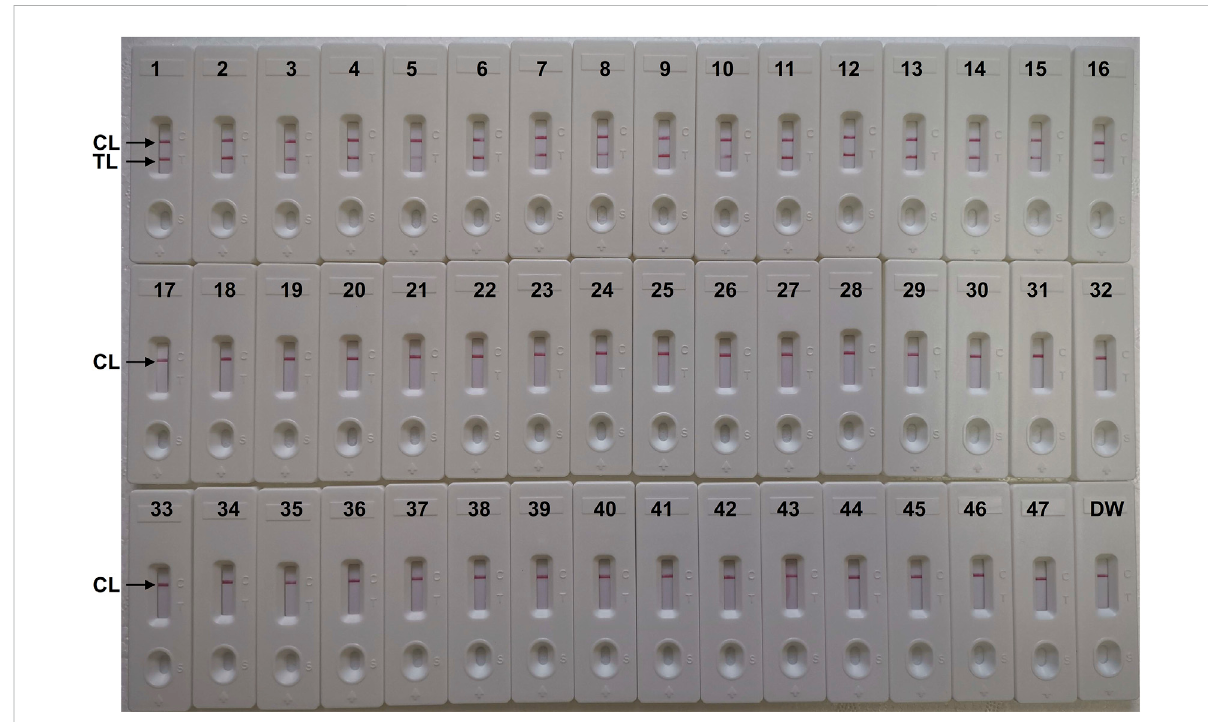
FIGURE 7 The speci fi city of C. albicans -LAMP-LFB assay for different strains. The C. albicans -LAMP-LFB assay was evaluated with different strains genomic DNA as templates. Two crimson lines (TL and CL) were appeared on the LFB, indicating positive results for the C. albicans isolates. Only a visibleredline(CL)atthedetectionzoneofLFB,reportingthenegativeresultsfornon- C.albicans strainsandblankcontrol(DW).Biosensor1,Positive control ( C. albicans ATCC 10231), Biosensors 2-16, isolated C. albicans strains; Biosensor 17, Candida dubliniensis ; Biosensor18, Candida tropicalis (ATCC 13803); Biosensors19-23, isolated Candida tropicalis strains; Biosensors 24-28, isolated Candida krusei strains; Biosensors 29-33, isolated Candida glabrata strains; Biosensors 34-38, isolated Candida parapsilosis strains; Biosensor 39, Cryptococcus neoformans ; Biosensor 40, Penicillium mameffei ; Biosensor 41, Candida stellatoidea ; Biosensor 42, Candida guilliermondi ; Biosensor 43, Aspergillus fl avus ; Biosensor 44, Staphylococcus aureus ; Biosensor 45, Klebsiella pneumoniae ; Biosensor 46, Pseudomonas aeruginosa ; Biosensor 47, Acinetobacter baumannii ; Biosensor 48, blank control (DW).